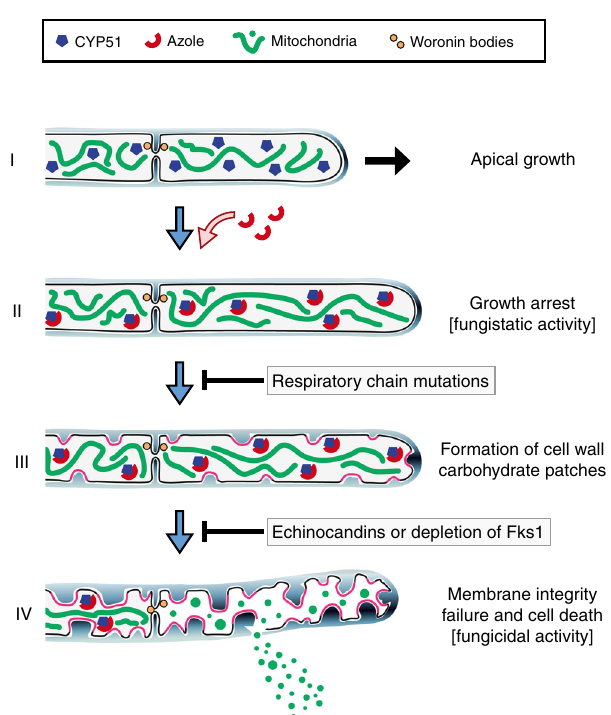
Fig. 10 Proposed model for the fungicidal activity of azole antifungals against A . fumigatus . Azole enters the growing Aspergillus hypha (I) and binds to the target enzyme lanosterol 14 α -demethylase (CYP51). The inhibition of CYP51 results in the depletion of ergosterol and suppression of growth in less than 1 h (II). This is followed by extensive delivery of membrane protein-loaded transport vesicles to the cell membrane (accentuation in pink) and the induction of excessive β -1,3-glucan and chitin synthesis at de fi ned spots along the hyphae (III). The continually increasing cell wall carbohydrate patches vigorously invaginate the plasma membrane, eventually resulting in membrane integrity failure and death of hyphae. Septa adjacent to damaged compartments are sealed off by Woronin bodies, specialized organelles that plug the septal pores, and improve survival of azole-exposed hyphae (IV). Inhibition of β -1,3-glucan synthesis, either by echinocandin antifungals or by reduced expression of the β -1,3-glucan synthase Fks1, attenuates the patch formation and delays the fungicidal activity of the azole. Mutants with a dysfunctional respiratory chain are strongly inhibited in growth but do not form cell wall patches, and thus do not die in the presence of lower inhibitory concentrations of